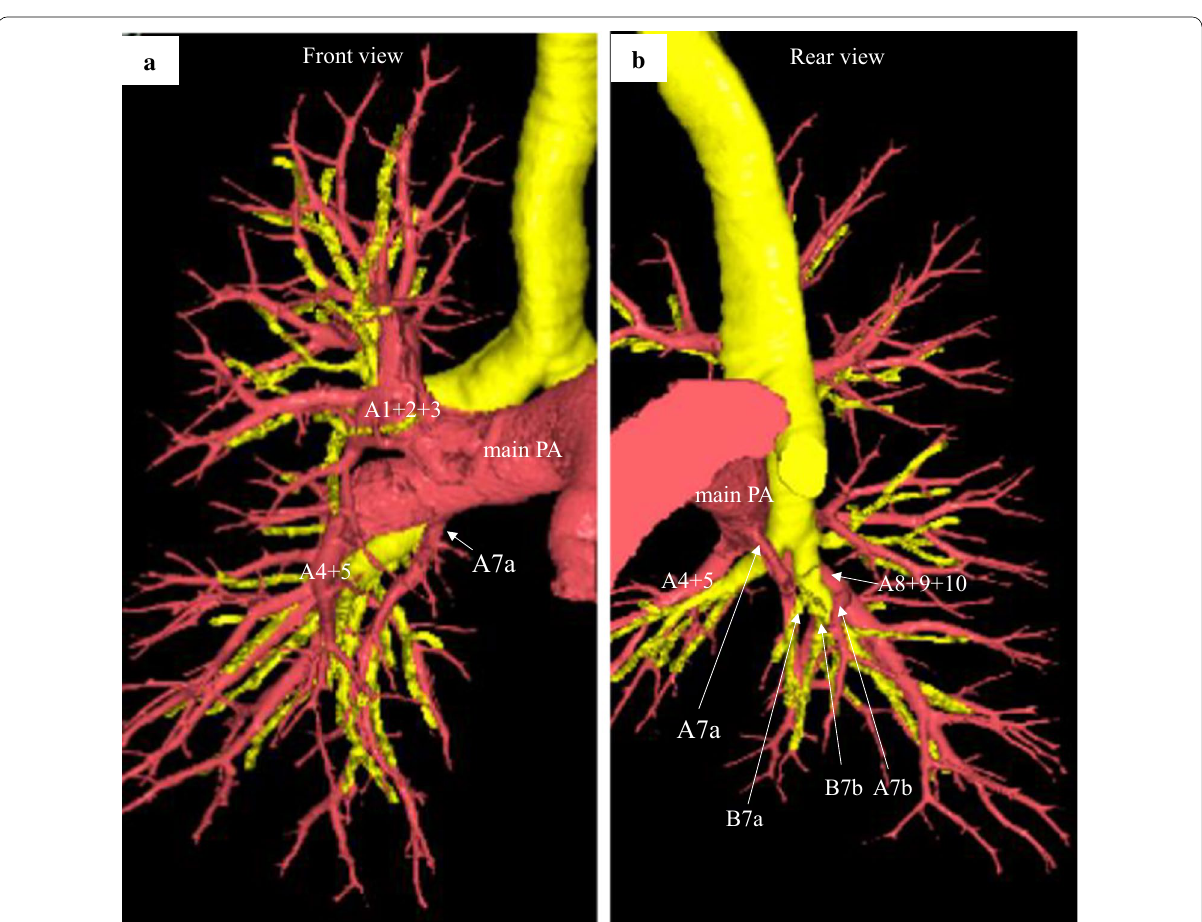
Fig. 2 Three-dimensional computed tomography angiography and bronchography images. a Front view. b Rear view. Reconstructed images of arteries (red), veins (blue), bronchi (yellow), and tumor (green). A artery; B bronchus; V